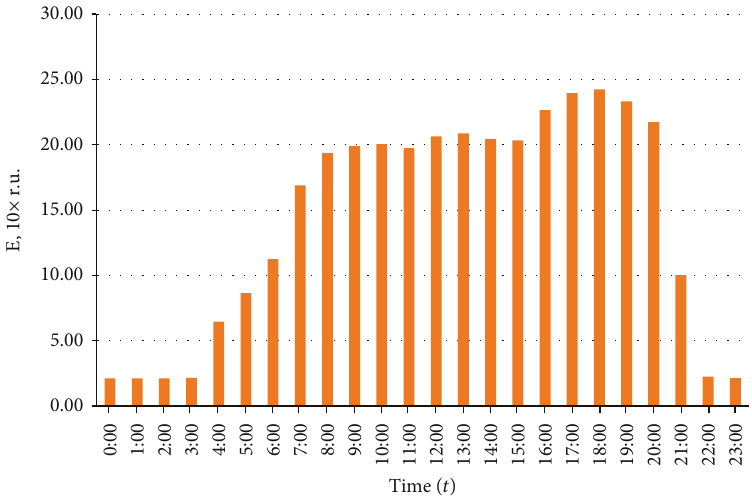
Figure 7: Utility lighting schedule after adjustment.